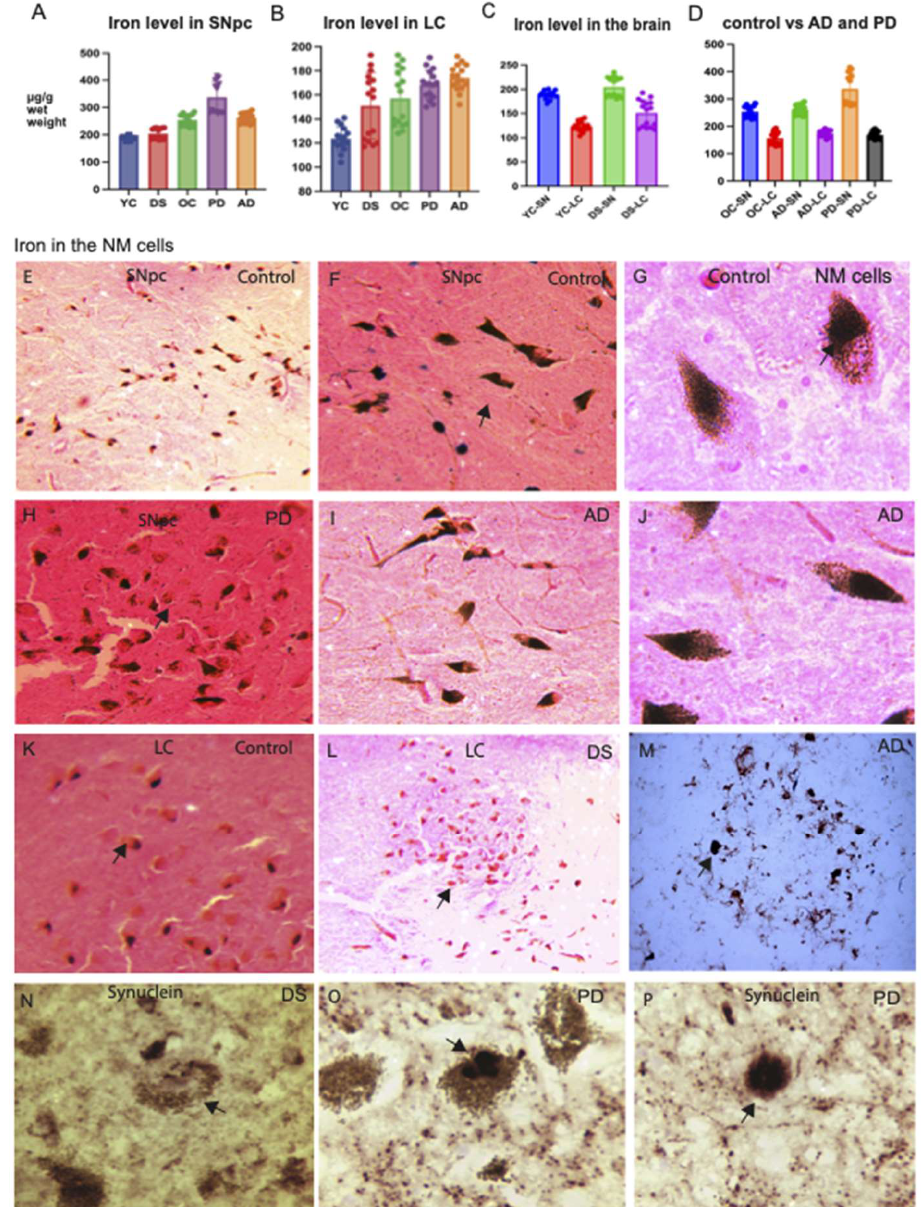
Figure 1. Non-haem iron concentration and neuromelanin expression in controls vs. disease brains. The non-haem iron concentration (NHIC) was measured in the SNpc and LC of AD, PD, DS, young control (YC), and old control (OC) subjects. The highest iron levels were found in the SNpc of PD brains ( A ). The concentration of iron in LC was significantly lower in all four groups compared to SNpc ( B ). Iron levels in SNpc and LC were compared in YC versus DS subjects ( C ) and in older controls (OC) versus AD and PD subjects ( D ). The concentration of iron in SNpc increases with age unlike that seen in LC ( R 2 = 0.76, p < 0.0001). SNpc and LC brain sections of AD, PD, and DS, and age-matched controls were stained with Pearls’ stain and in the control subjects’ SNpc, black granular iron molecules were visible in the neuromelanin (NM) containing cells ( E – G ). In higher magnification, expression was visible in the damaged NM cells of the PD ( H ), whereas intact NM cells with processes were visible in the AD brains without any cell damage ( I , J ). Neuromelanin content in the LC neurons in control brains was low ( K ), and even lower in the DS subjects ( L ). Iron accumulation was seen in senile plaques in AD brain ( M ) and α -synuclein protein expression was located in the neuromelanin cells in the DS and in PD brains ( N – P ). Lewy bodies were present inside the NM cells ( O , P ). Scale bar: ( E , L , K ) = 100 µ m, ( F , H , I ) and M = 50 µ m, ( G , J , N – P ) = 20 µ